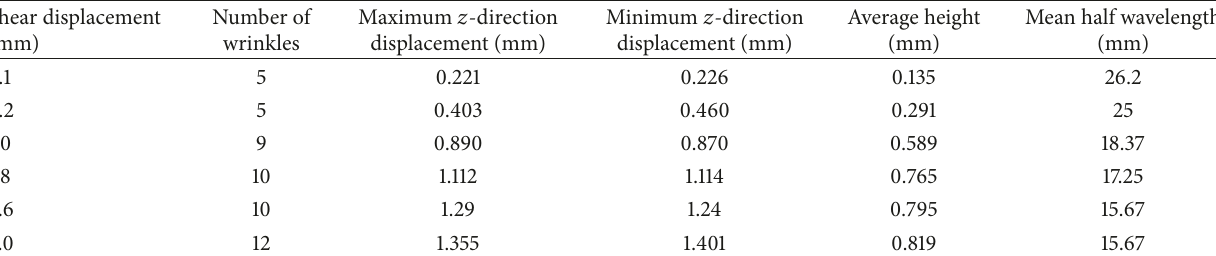
Figure 11: Corresponding buckling mode shapes. Table 6: Influence of shear